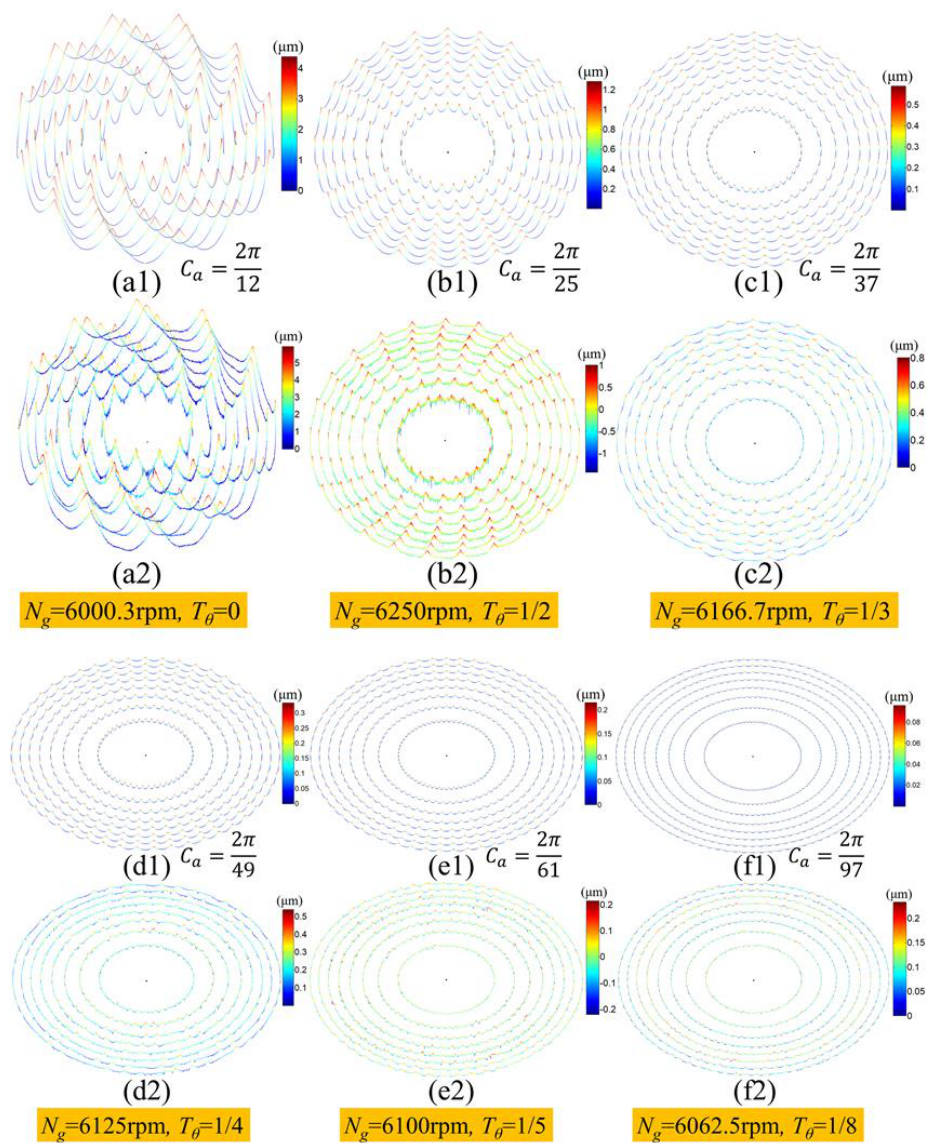
Figure 12. Simulation and the measurement results of the circular waviness profile on each circle surface of the Fresnel micro-structured molds: ( a1–f1 ) the simulation results; ( a2–f2 ) the measurement results.